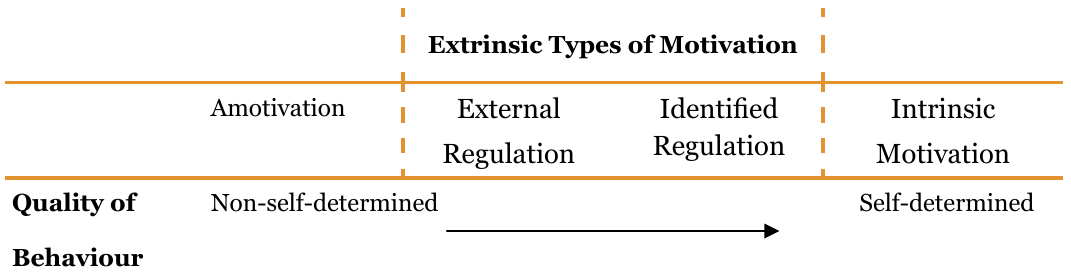
Figure 1 . Elements of the SDT model of motivation used to measure motivation in this